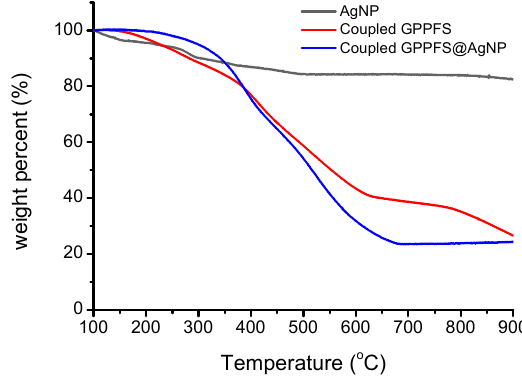
Figure 6. TGA analysis of bare AgNP, DA-DCMA coupled glycosylated PPFS (GPPFS) chains, and GPPFS coupled to AgNPs (GPPFS@AgNPs).